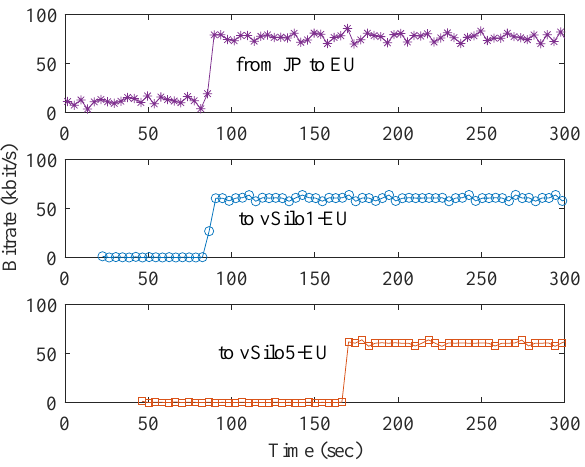
Figure 11. MQTT traffic of context